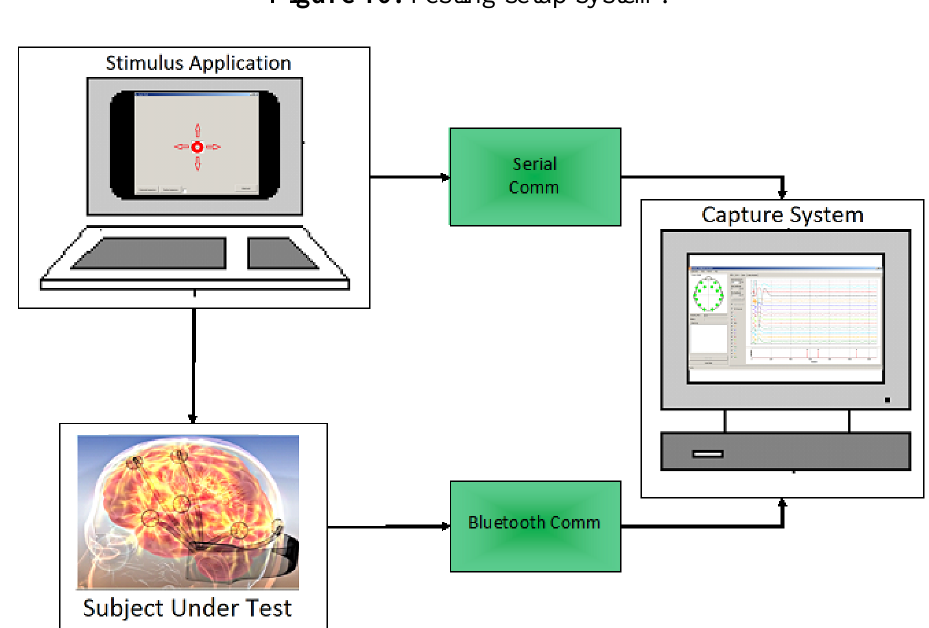
Figure 16. Testing setup